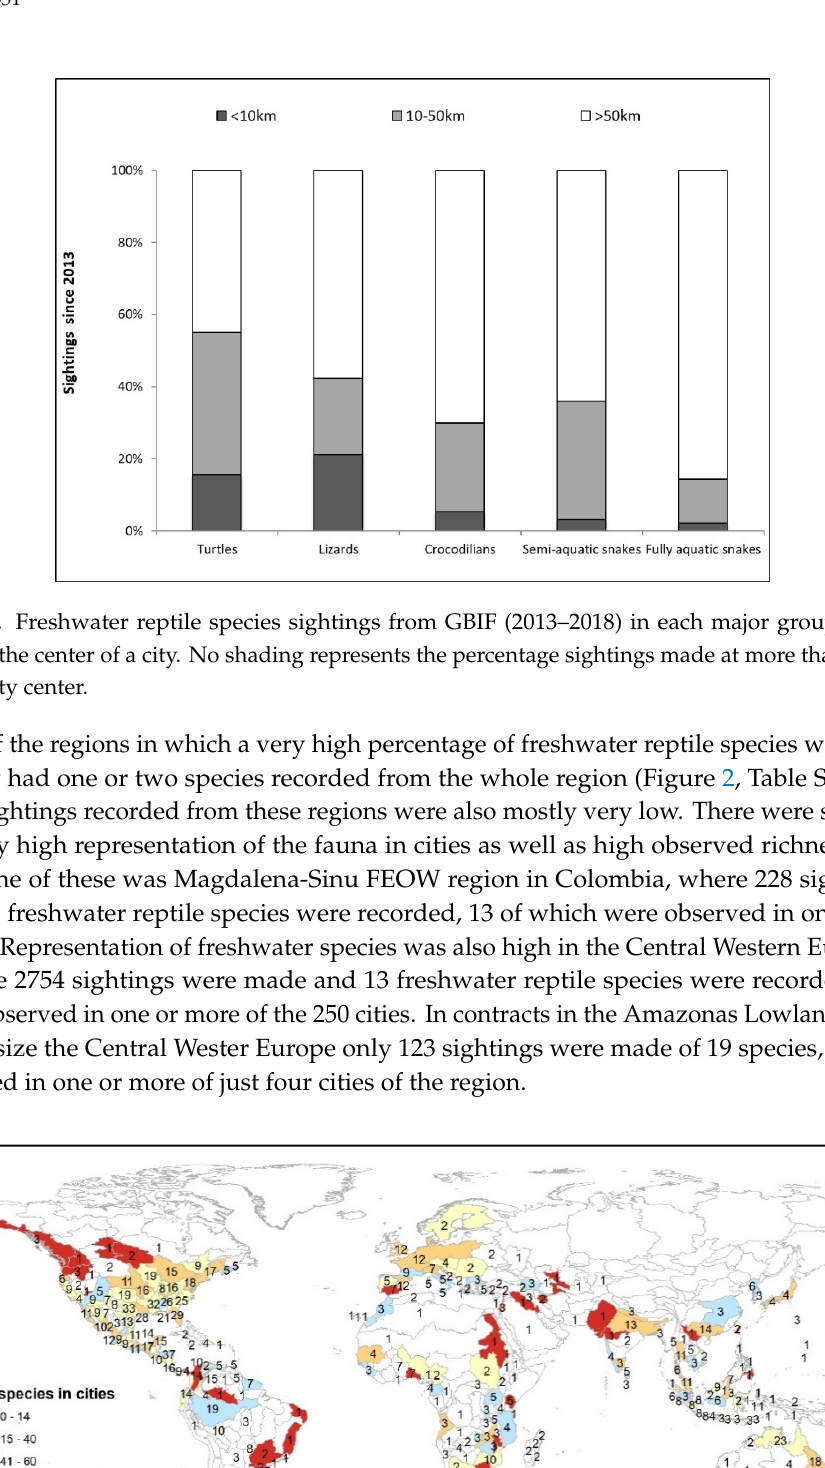
Figure 9. Regional species richness of Freshwater reptiles and their level of representation in cities of the region. The numbers represent number of species of freshwater reptiles recorded in GBIF (2013– 2018) from each Freshwater Ecoregions of the World (FEOW) region. The colors represent the level of representation of this fauna within 10 km of the center of a city in that FEOW Region. One invasive species Trachemys scripta was omitted from the data used to produce this map.